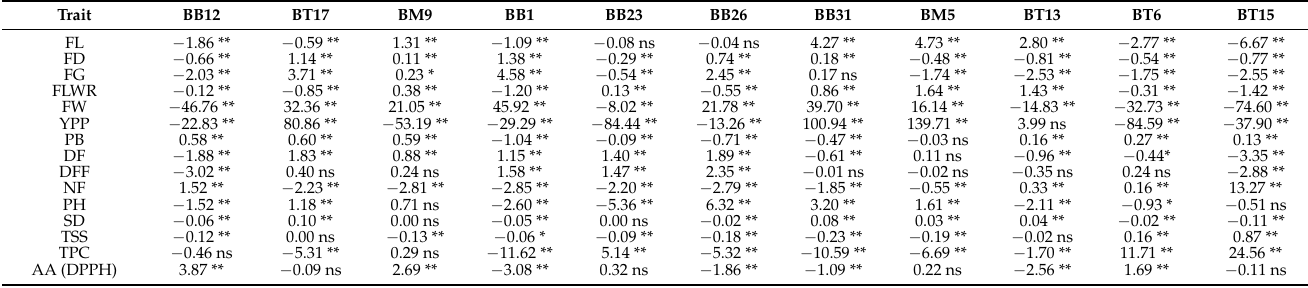
Table 6. Estimation of general combining ability (GCA) effects on parents for 15 traits of eggplant.